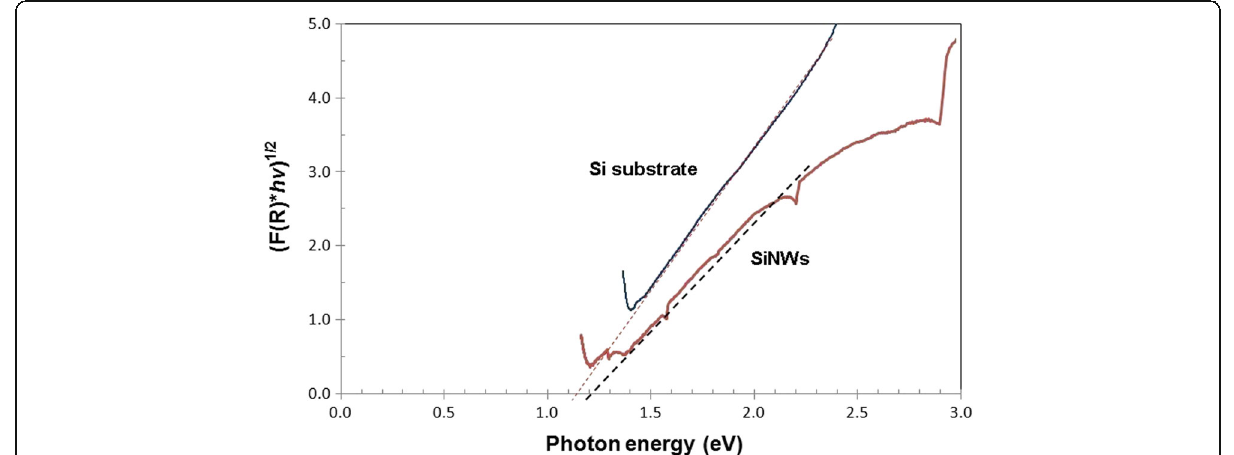
Fig. 7 Plot of (F(R)* h ν ) 1/2 versus photon energy ( h ν ) for a Si substrate and the SiNW